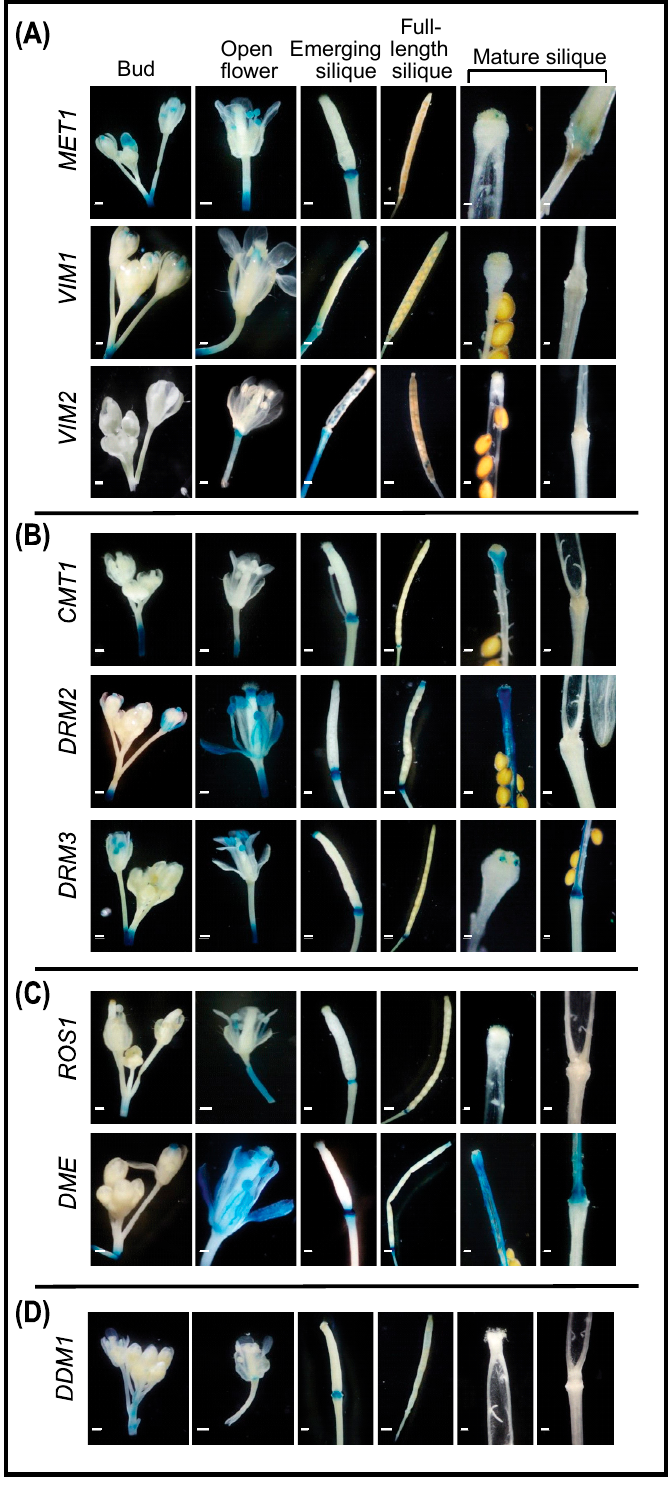
Figure 3. Promoter activity of DNA methylation and demethylation-related genes in floral tissues and organs. A–C: Histochemical localization of GUS activity directed by promoters of the CG methylation-related genes MET1 , VIM1 , and VIM2 ( A ), the non-CG and RdDM-related CMT1 , DRM2 , and DRM3 methyltransferases ( B ), and the demethylases ROS1 and DME ( C ), and DDM1 ( D ) in inflorescence buds, open flowers, emerging siliques, distal end of mature siliques, and proximal end of mature siliques. Scale bar = 5 mm.